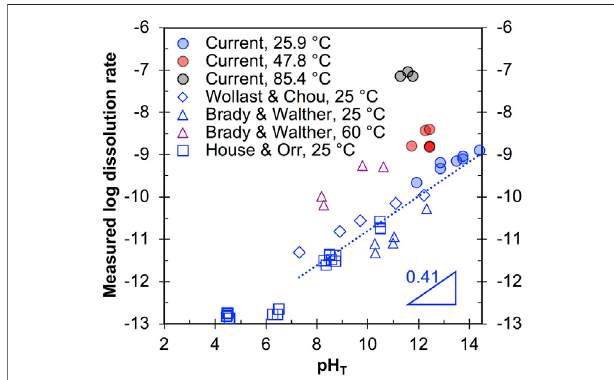
FIGURE 3 | The dissolution rate data (mole/m 2 /s) as a function of pH T and different temperatures. Literature data from House & Orr (House and Orr, 1992), Brady & Walther (Brady and Walther, 1990), and Wollast & Chou (Wollast et al., 1988; Dove and Elston, 1992) (empty square, star, and pentagon, respectively) are compared with the results of this study ( fi lled circles). The dotted line is given to describe the overall trend of the room temperature data at pH T ~7 – 14.